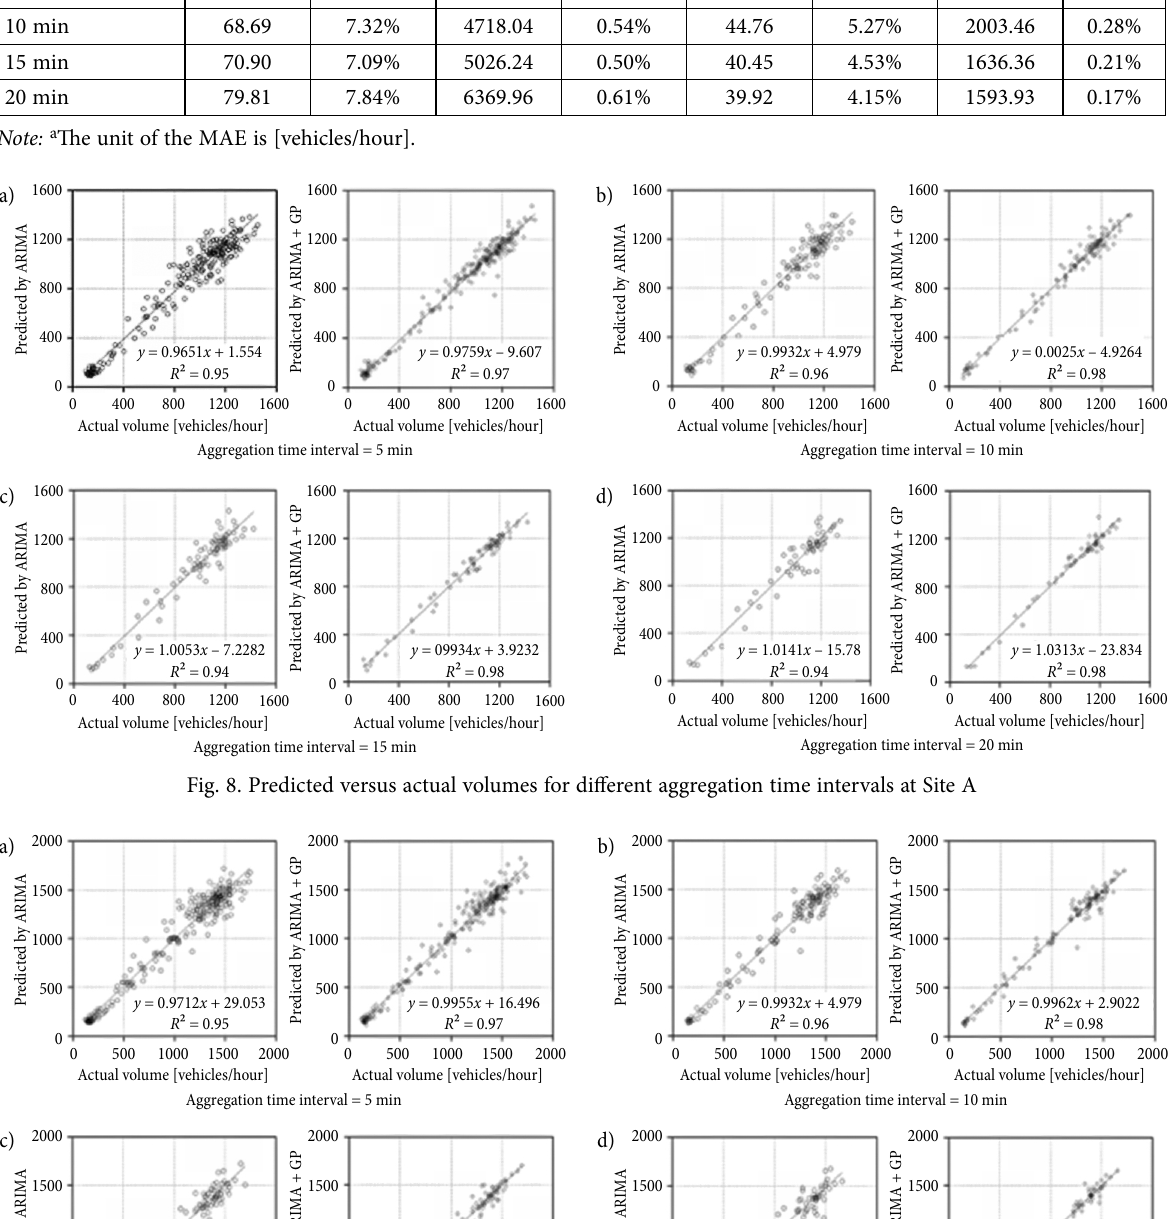
Table 9. Comparison of the predictive performance of the models for Site B in Scenario 1 Aggregation level